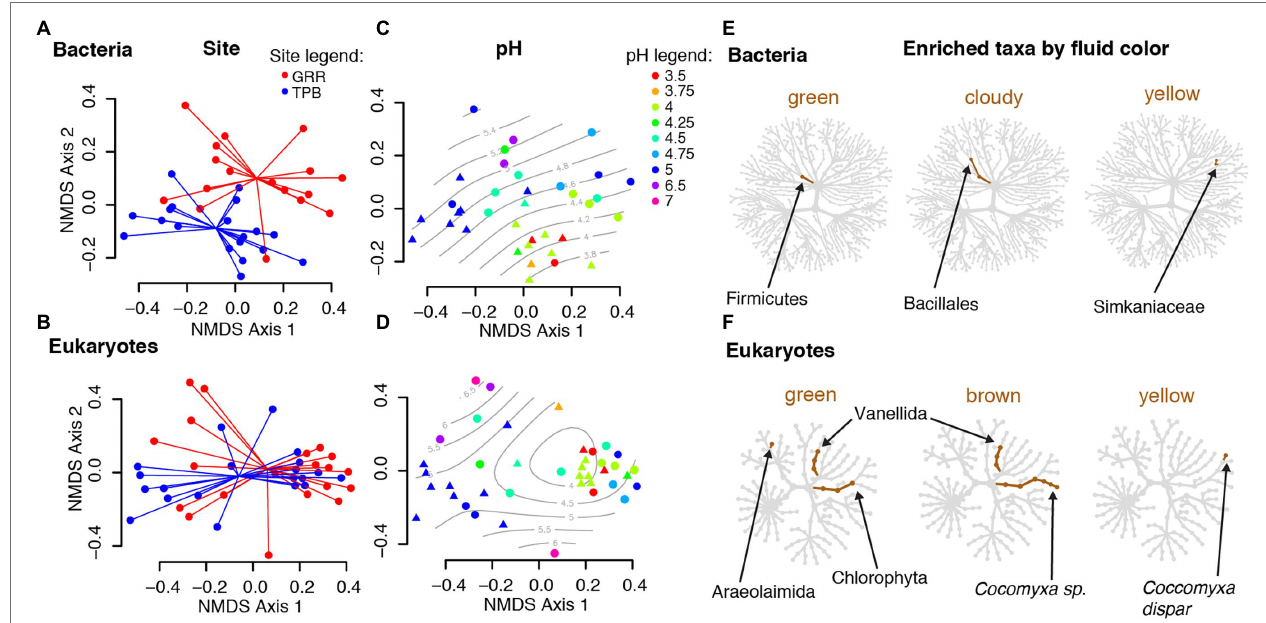
FIGURE 2 | Differences in Cephalotus follicularis microbial community composition. (A–D) Beta diversity nonmetric multidimensional scaling (NMDS) plots using unweighted UniFrac distances for bacterial and eukaryotic community composition by collecting site and fluid pH. Points in plots (A) and (B) are colored by site and connected at the mean for each site, while points in plots (C) and (D) are colored by pH and overlaid with a smooth surface representing pH. (E,F) Taxonomic heat trees for bacteria and eukaryotes showing taxa significantly enriched in pitcher fluids of different colors when compared with clear fluid. Taxa shown are enriched by a log 2 ratio median proportion of